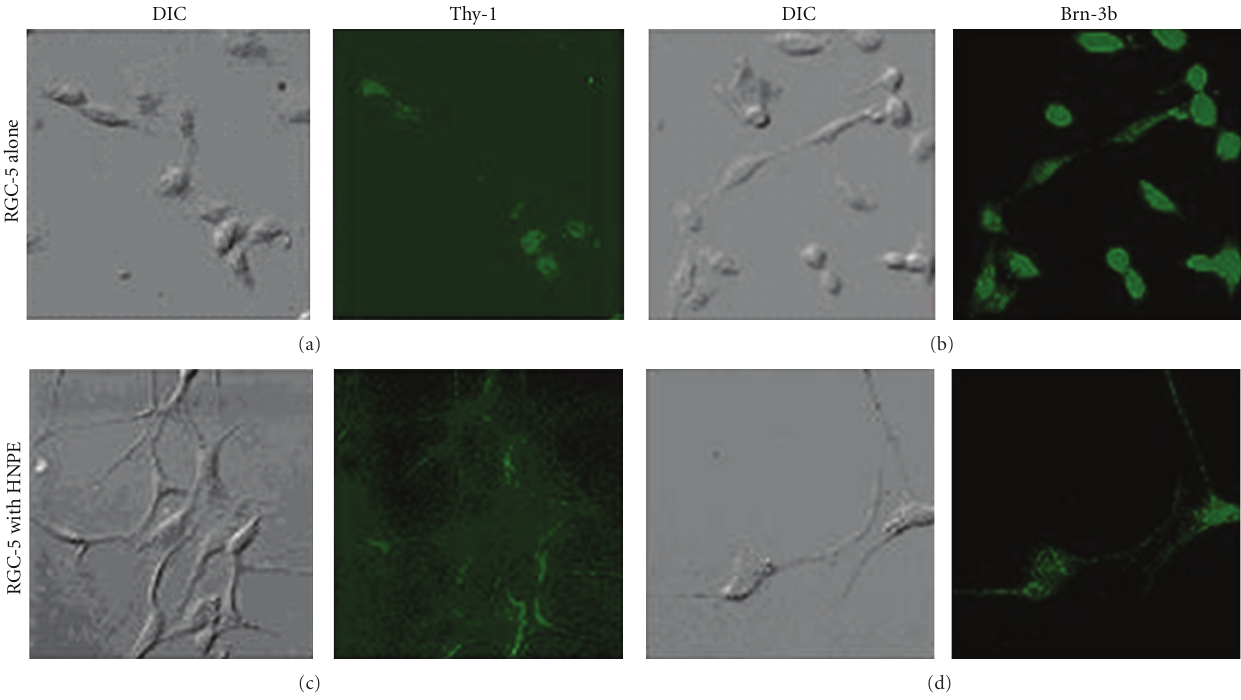
Figure 2: Immunocytochemical analysis of Thy-1 and Brn-3b expression in RGC-5 cells di ff erentiated by treatment with HNPE cell conditioned SF-medium. Staining with antibodies to the cell surface glycoprotein, Thy-1, have been commonly used as a marker to identify retinal ganglion cells. After cultivation with HNPE conditioned medium, RGC-5 cells have an enhanced Thy-1 expression, compared to the undi ff erentiated cells. RGC-5 cells without cultivation with HNPE conditioned medium express Brn-3b in a di ff erent pattern compared with treated RGC-5 cells. Specifically, Brn-3b has a nuclear localization in RGC-5 cells without cultivation with HNPE conditioned medium; however, upon treatment, RGC-5 cells express Brn-3b in a more punctate cytosolic